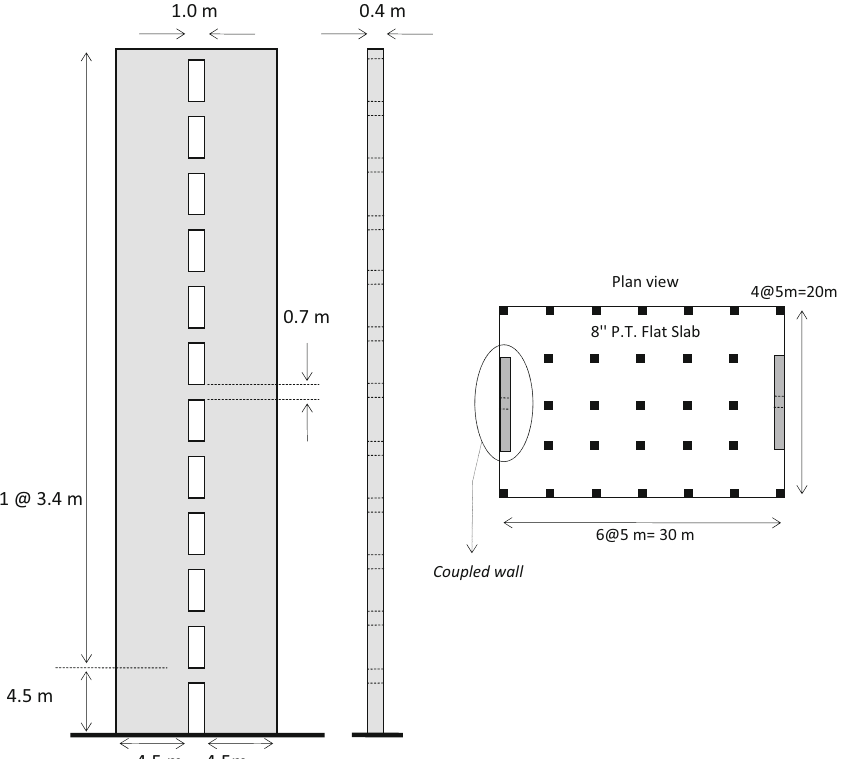
Fig. 4 Elevation of 12-story building, and floor plan applicable to 8, 12, and 20-story buildings.